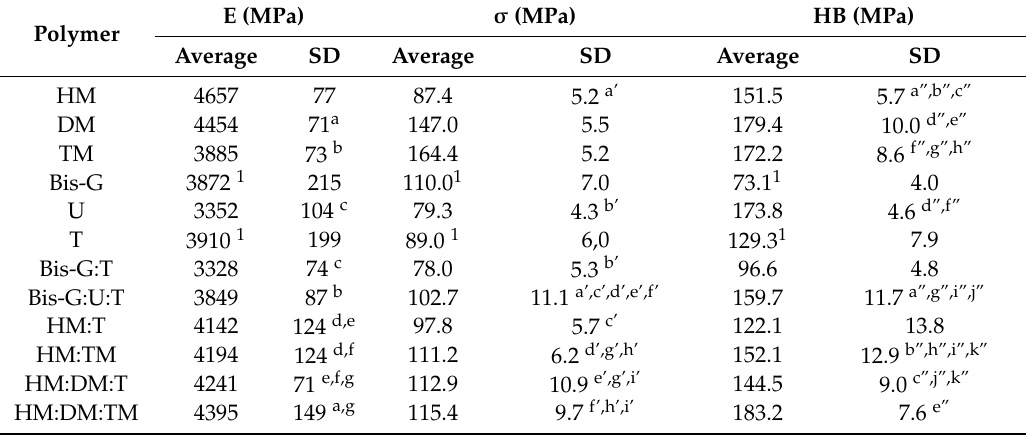
Table 5. The mechanical properties of the studied polymers: flexural modulus (E), flexural strength ( σ ) and hardness (HB). The majority of the results are statistically significant ( p ≤ 0.05). Pairs which have statistically insignificant results ( p > 0.05) are highlighted with the letters: a–g – for the E , a’–i’ – for the σ , and a”–k” – for the